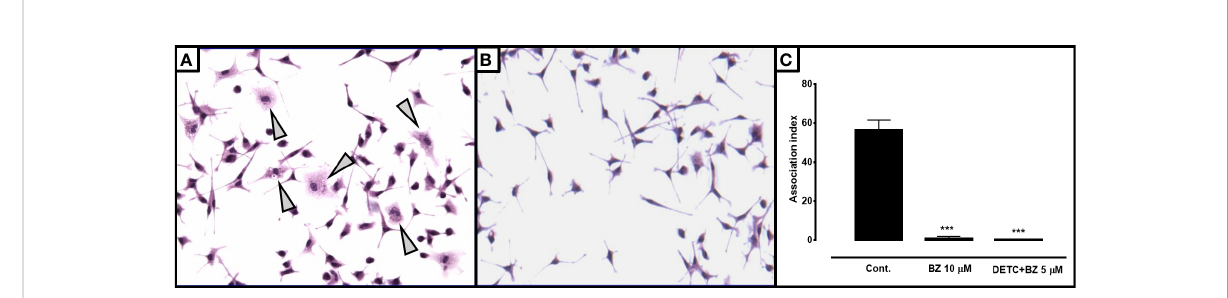
FIGURE 10 Effect of DETC alone or combined with BZ on the T. cruzi -macrophage interaction. BALB/c mice peritoneal macrophages were infected with Colombiana strain bloodstream trypomastigote forms 1:10 phagocyte/parasite ratio. Control cultures (A) showing several parasitized macrophages as well as larger number of intracellular forms per phagocyte (arrowheads) than cells treated with the combination 5 µM DETC + 5 µM BZ (B) . Magni fi cation 200X. The association index in cultures treated with 10 µM BZ or the 5 µM DETC + 5 µM BZ combination after 24